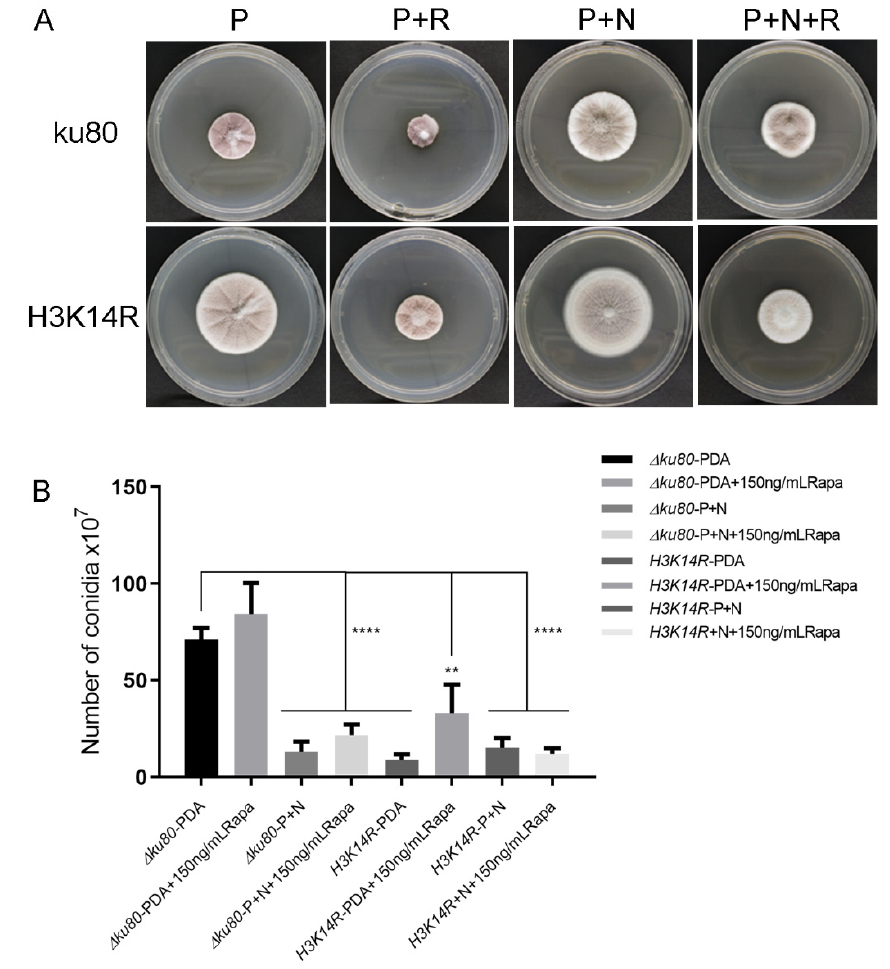
Figure 5. Rapamycin inhibits the growth of P. lavendulum . ( A ) Comparison of colony morphology of ku80 and H3K14R strains in PDA (P), PDA + rapamycin (P+R), PDA + (NH 4 ) 2 SO 4 (P+N) and PDA + (NH 4 ) 2 SO 4 + Rapamycin (P+N+R). ( B ) Conidiation comparison of ku80 and H3K14R strains on the four media listed in (A). **, p<0.01; ****, p<0.0001.